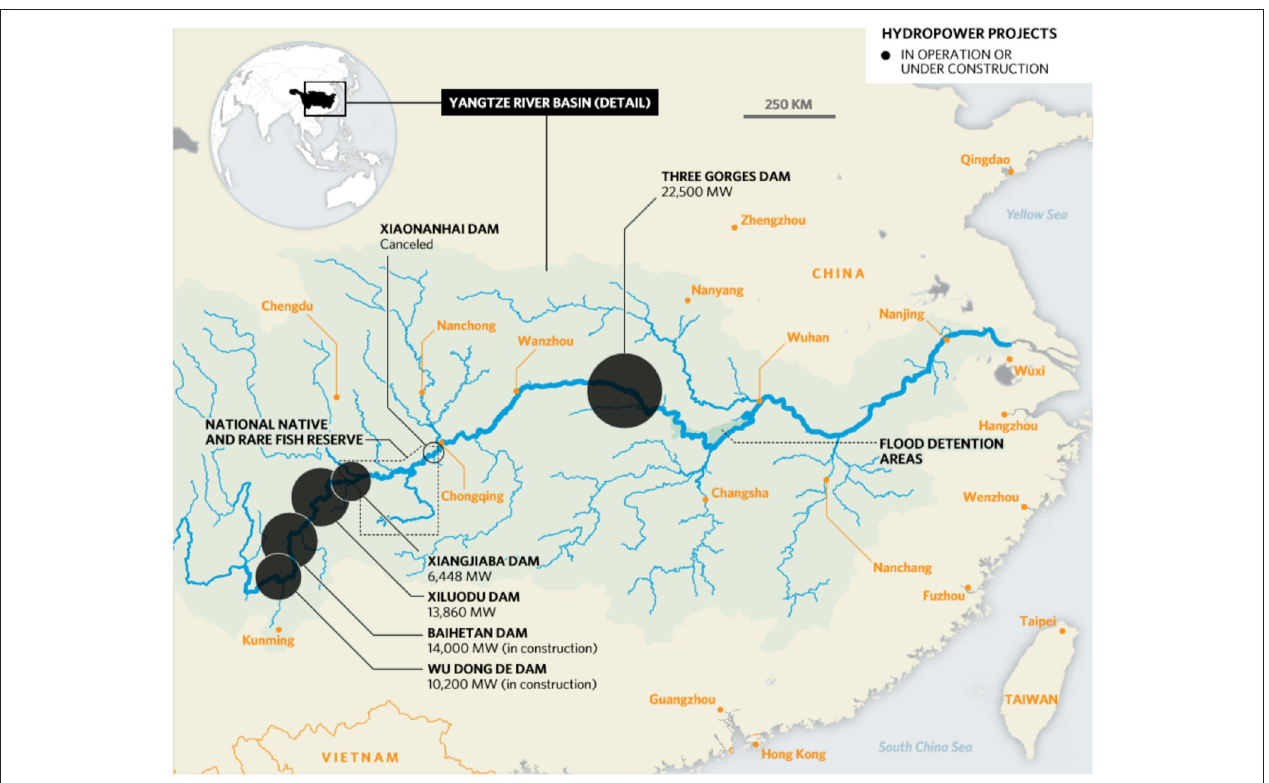
FIGURE 1 | The Yangtze River and the hydropower development in the main stem. Reproduced from (Opperman et al., 2017) with permission from The Nature